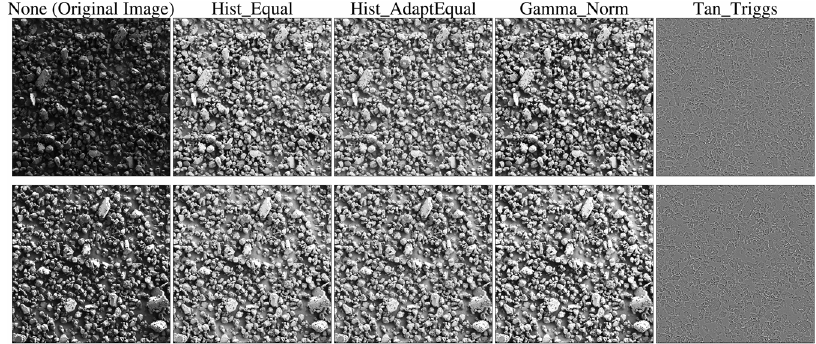
Fig. 5 Effects of intensity normalizations. This fi gure shows results of applying different intensity normalization